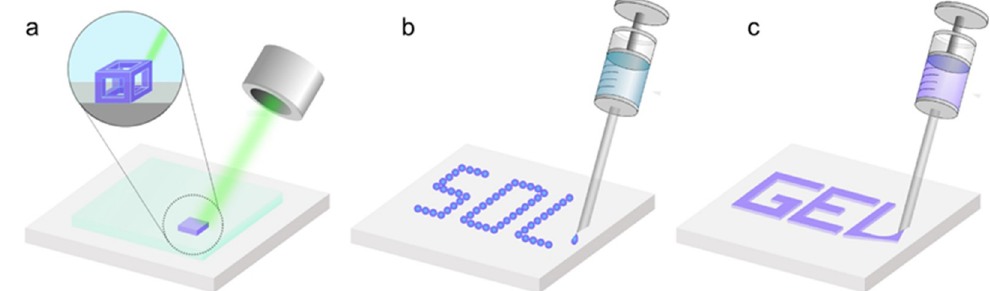
Figure 3. Schematic depiction of the three main 3D‐printing techniques employed for the fabrication of aerogels. ( a ) Stereolithography, where a laser is used to transform the sol to a gel during the printing process; ( b ) ink‐jet printing, where a solution is printed into its desired structure prior to observing gelation; and ( c ) direct ink writing, where the gel is formed prior to printing and the gel is extruded in order to achieve the desired structure.